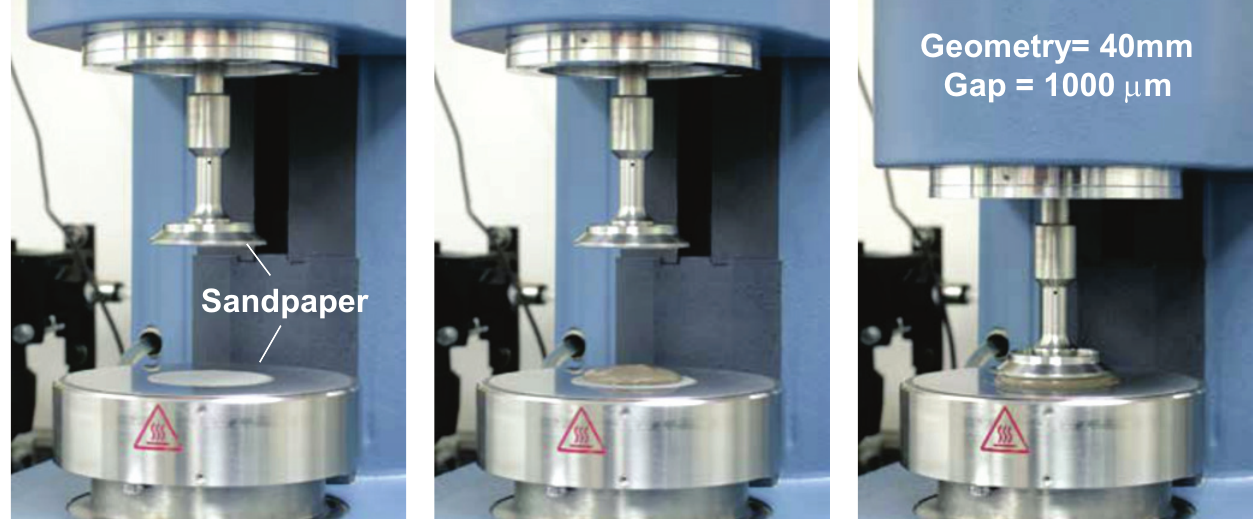
Equipment used for oscillatory rheometry. Sandpaper was glued on the Peltier plate and under the geometry to prevent paste slipping during the test